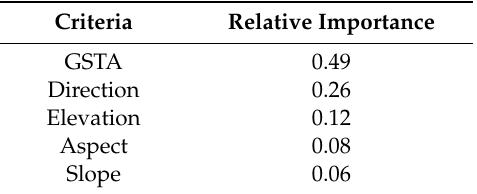
Table 2. The relative importance of the